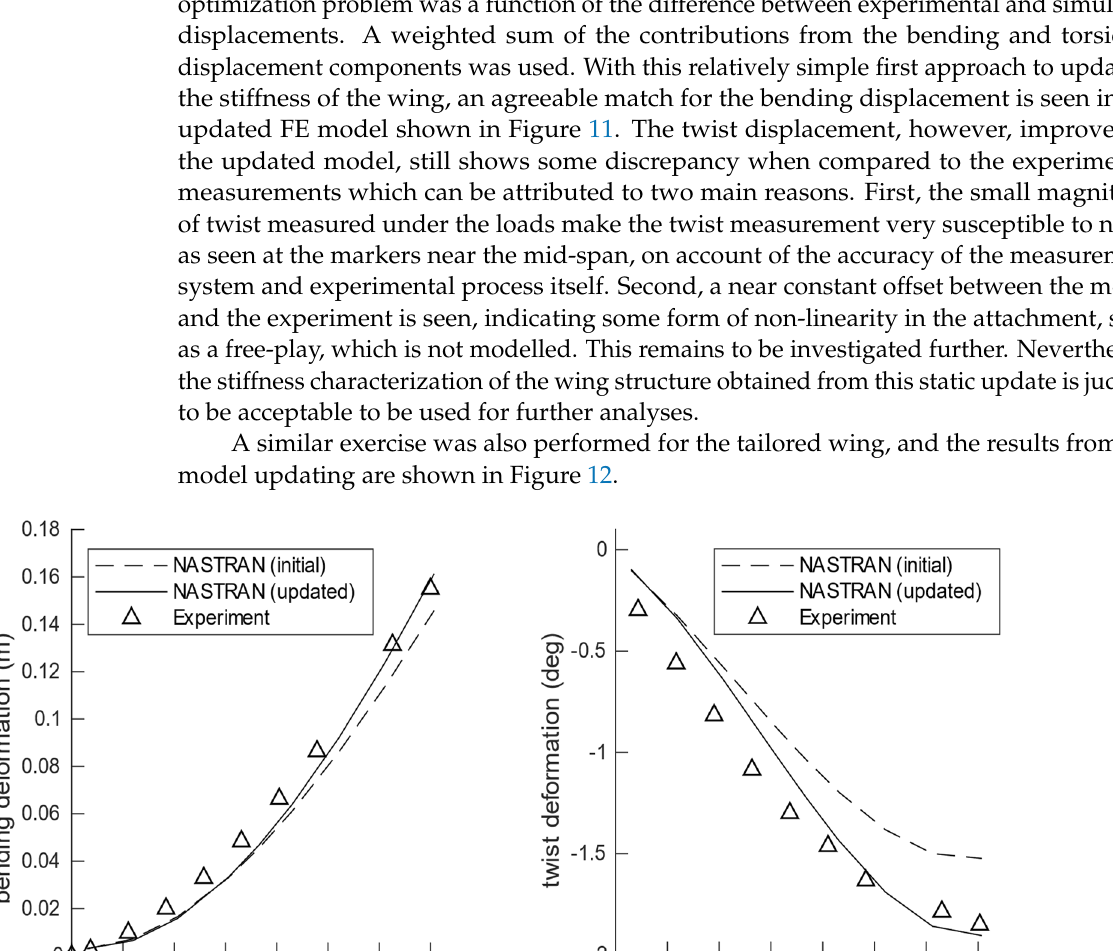
Figure 12. Displacement ( left ) and twist ( right ) comparing initial FE model, updated FE model and static test experiments for the tailored